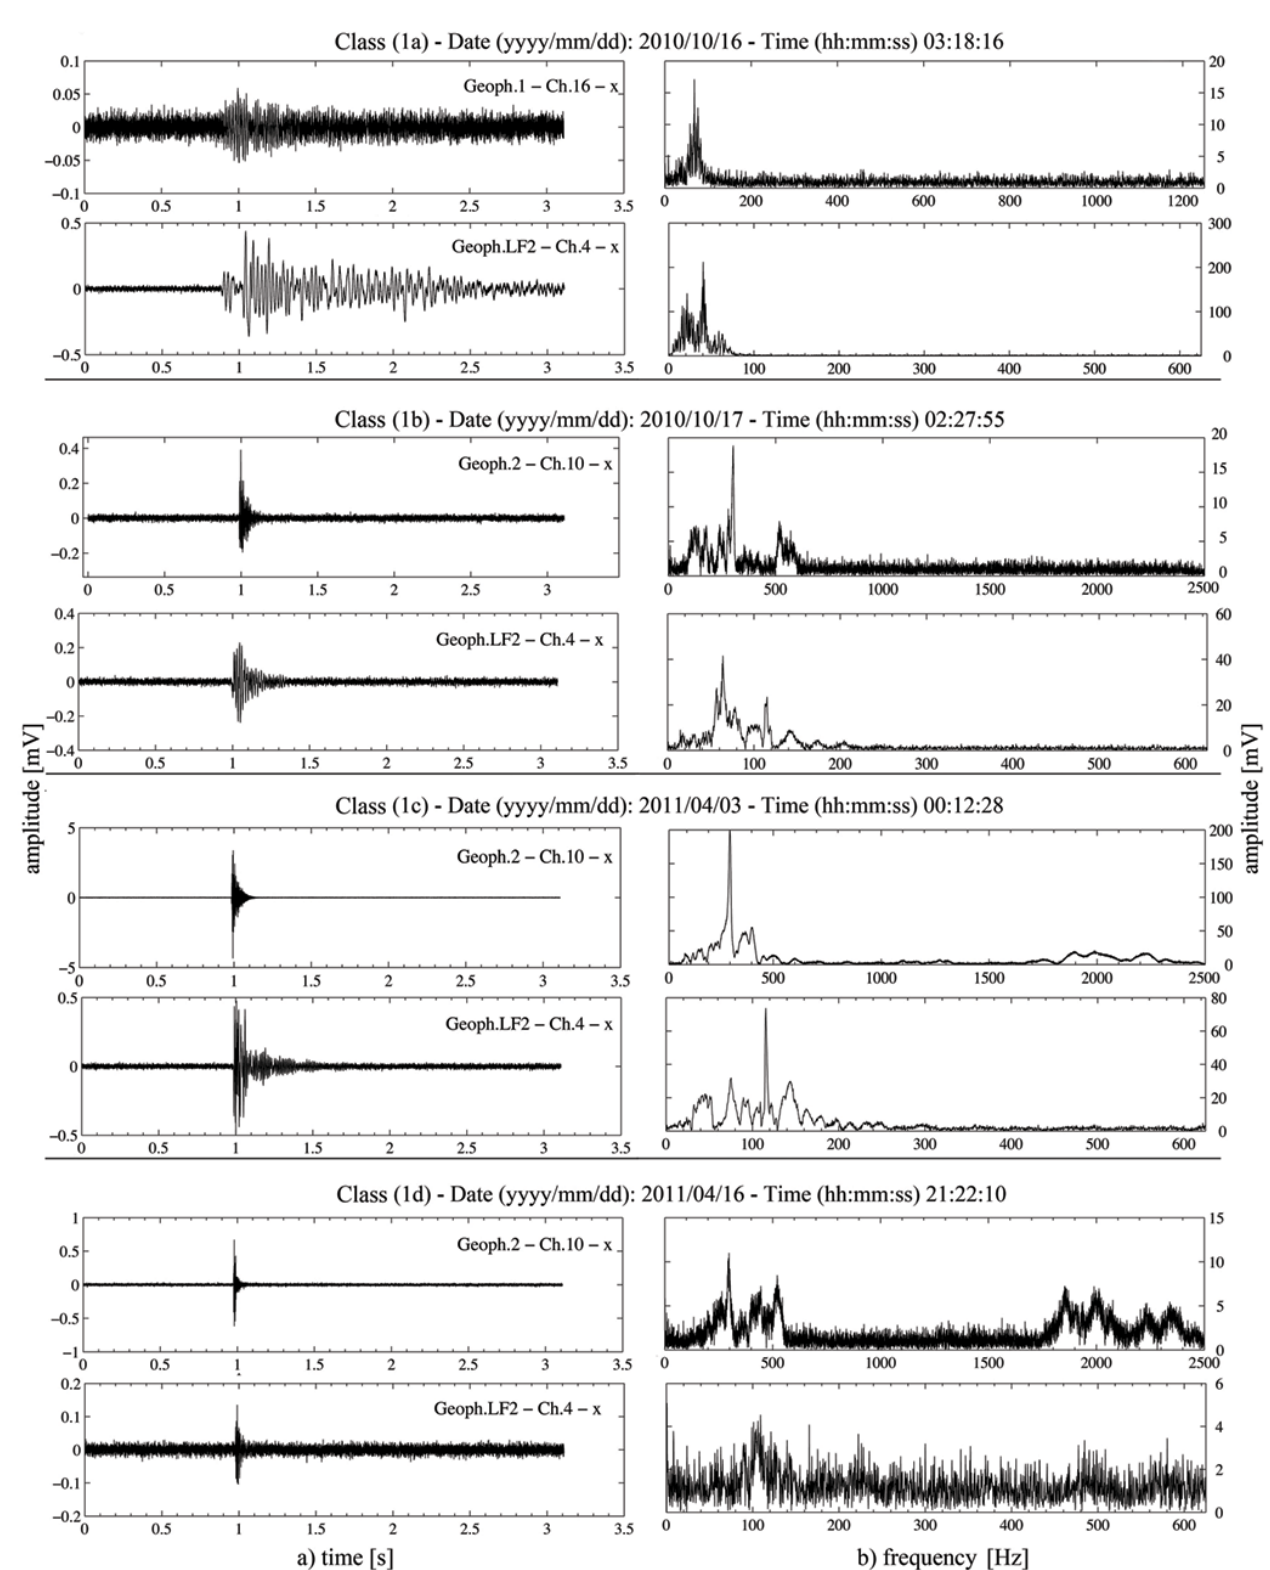
Fig. 7. Characteristics of the identified four classes of single events: example of a signal recorded by an HF and a LF geophone (a) in time domain and (b) in frequency